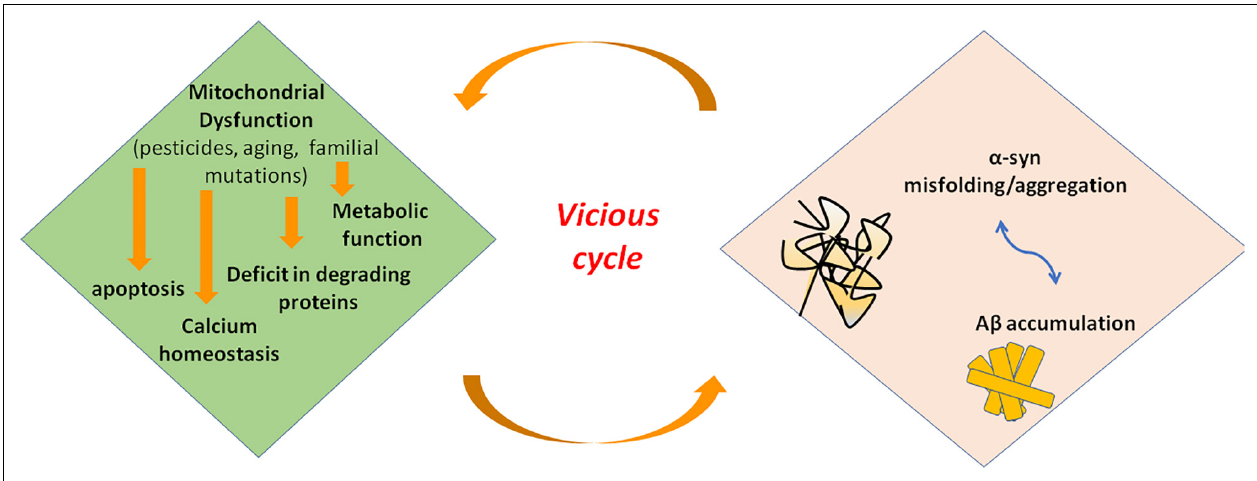
FIGURE 3 | Interaction of misfolded proteins and mitochondria in neurodegenerative disorders. Mitochondrial dysfunction leads to deficit in metabolic function and calcium homeostasis, apoptosis, and possibly impairment of the ability of mitochondria to degrade and import proteins. Amyloidogenic proteins such α -syn and A β accumulate in cytosol and aggregate, preventing also mitochondrial import of other proteins. These events increase mitochondrial dysfunction in a vicious cycle. α -syn, alpha-synuclein; A β , amyloid beta; ROS, reactive oxygen species.